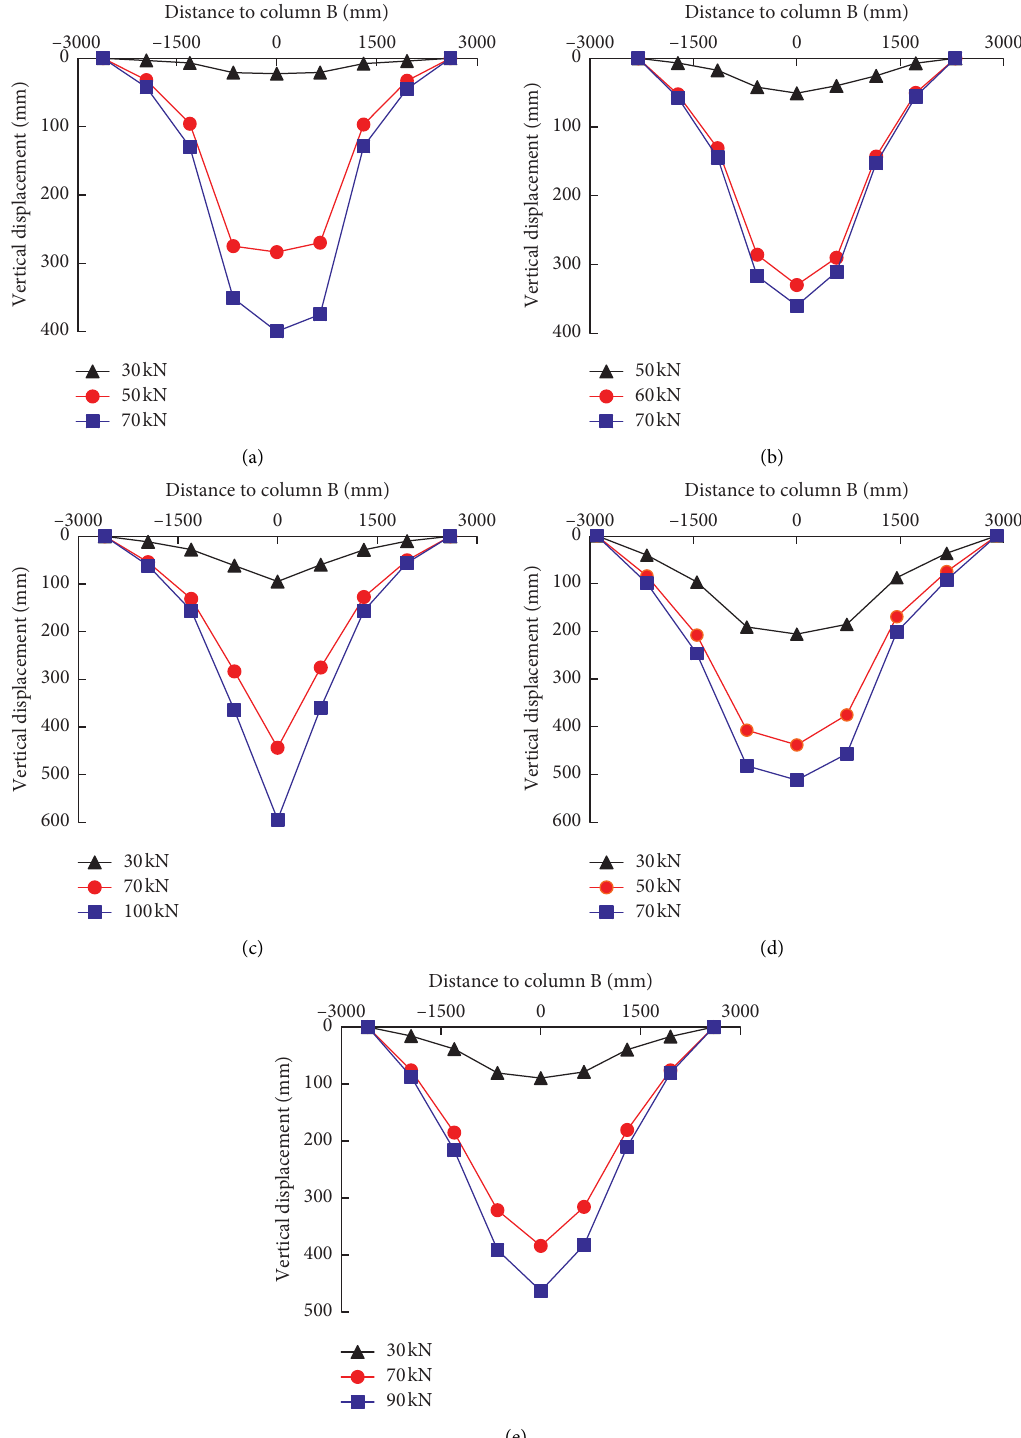
Figure 10: Overall deformation of frame beams. (a) S1. (b) S2. (c) S3. (d) S4. (e)